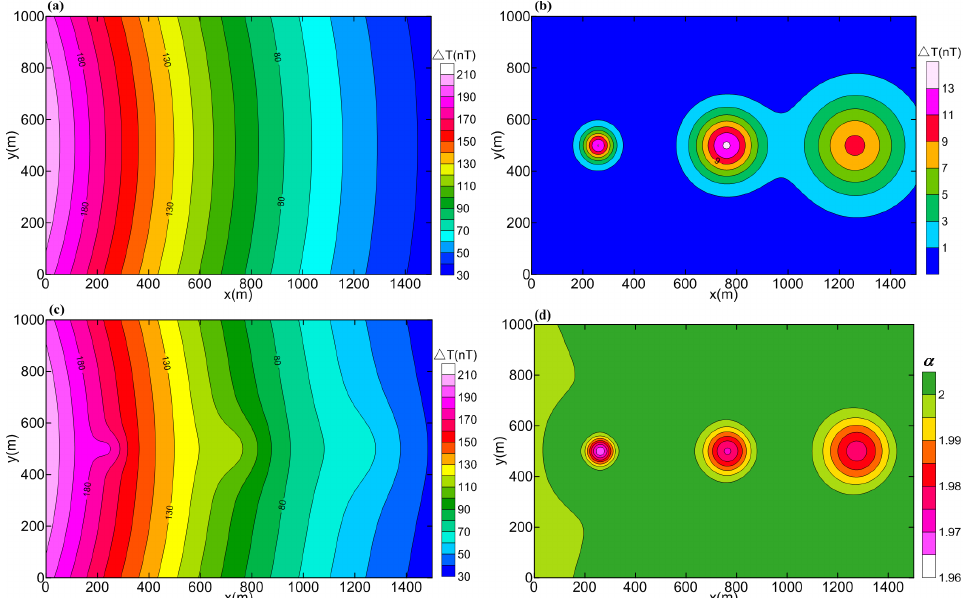
Fig. 2. Application of singularity mapping technique in theoretical magnetic anomalies: (a) a regional magnetic field generated by a quadratic trend surface; (b) local magnetic anomalies produced bythree spheres with different burial depths and radii; (c) synthetic magnetic anomalies which are the superposition of the local anomalies on the regional field; and (d) estimated singularity α value derived using the window-based